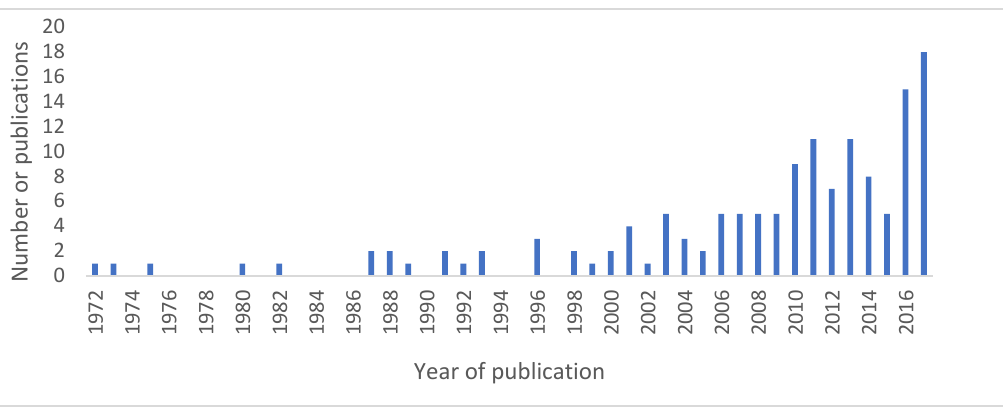
Figure 2. Number of publications over time.